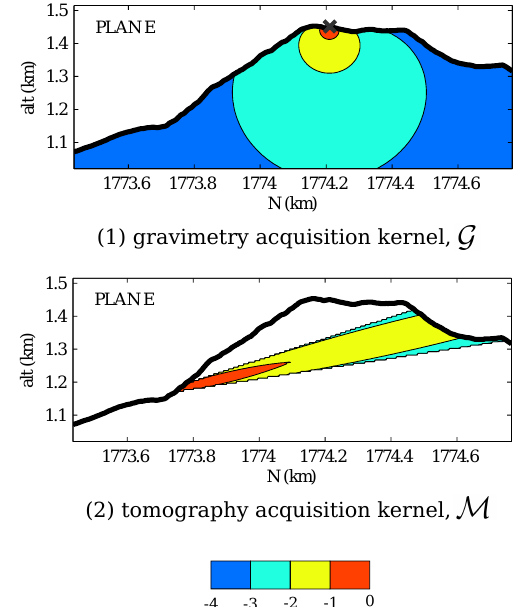
Figure 4. (1) Acquisition kernel of a gravimetric measurement; (2) acquisition kernel for a single observation axis of the muon tele- scope. The kernels are normalized with reference to their maximum value and printed in a log 10